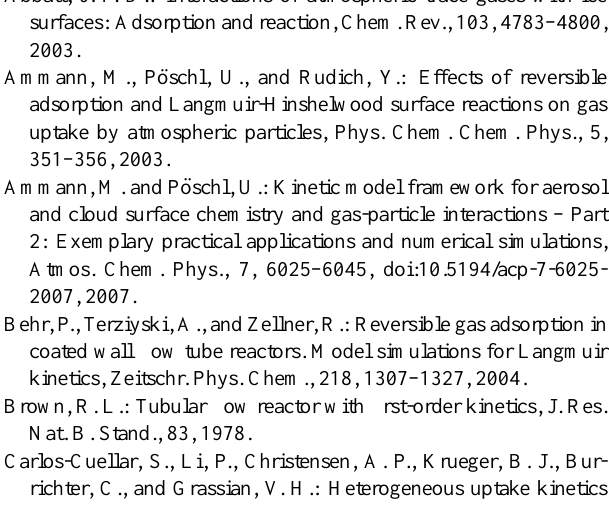
Table 2: Methods used in the study of heterogeneous pro-